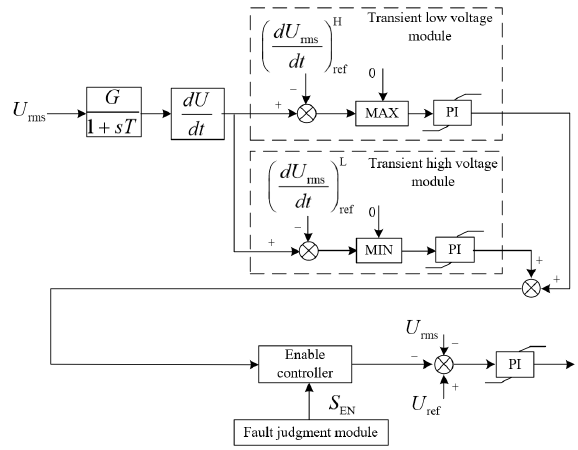
Fig. 6. Schematic diagram of additional transient voltage regulation